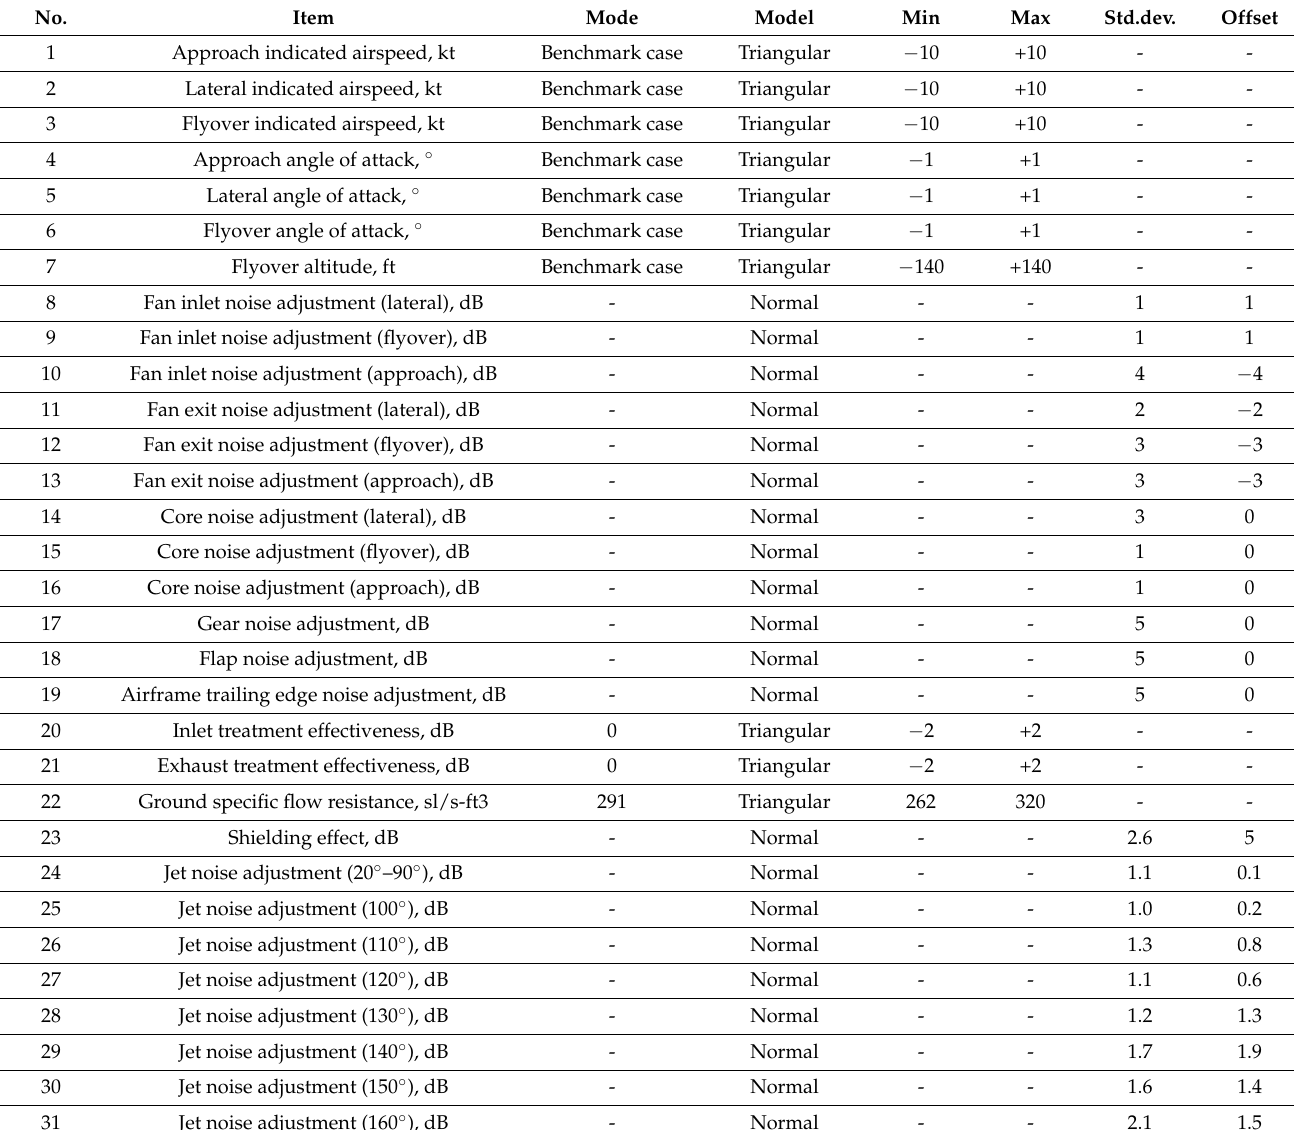
Table 3. Uncertainty models used in the